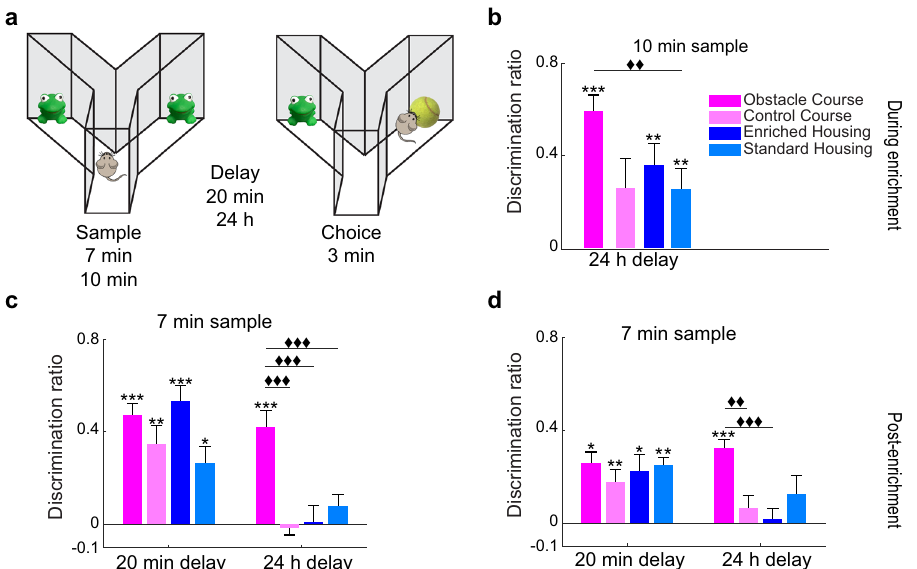
Fig. 2 SOR — Enhancement of long-term object memory with OC training exceeds EH effects. a Schematic representation of the spontaneous object recognition (SOR) experiments. b Task performance with a 10-min sample and a 24-h delay during the 9th week of enrichment. The OC group demonstrated a signi fi cantly higher discrimination ratio (DR) compared to the SH group. OC, EH, and SH groups showed DRs above chance. c SOR task performance with a suboptimal sample time at two delay durations during the 10th week of enrichment. With a 20-min delay, all groups signi fi cantly discriminated above chance. With an increased delay to 24 h, the OC group DR was signi fi cantly higher compared to all other groups. (Delay x group interaction p < 0.001, delay main effect p < 0.001, and group main effect p = 0.003). Only the OC group showed a DR above chance. d Replication of c, but completed 1-month post-discontinuation of enrichment. With a 20-min delay, all groups signi fi cantly discriminated above chance, demonstrating intact object memory. With an increased delay to 24 h, the OC group demonstrated enhanced object memory, performing signi fi cantly better than the EH and CC groups (delay x group interaction p = 0.057, delay main effect p = 0.01, and group main effect p = 0.023). The OC group was the only group to discriminate the novel object signi fi cantly above chance. * p < 0.05, ** p < 0.01, *** p < 0.001 indicate signi fi cant two-tailed paired-sample t-tests (choice DR vs. sample DR). ♦♦ p < 0.01, ♦♦♦ p < 0.001 indicate a signi fi cant difference between groups (two-tailed independent samples t -test, Bonferroni correction p = 0.0083). Error bars represent the standard error of the mean (s.e.m.) across